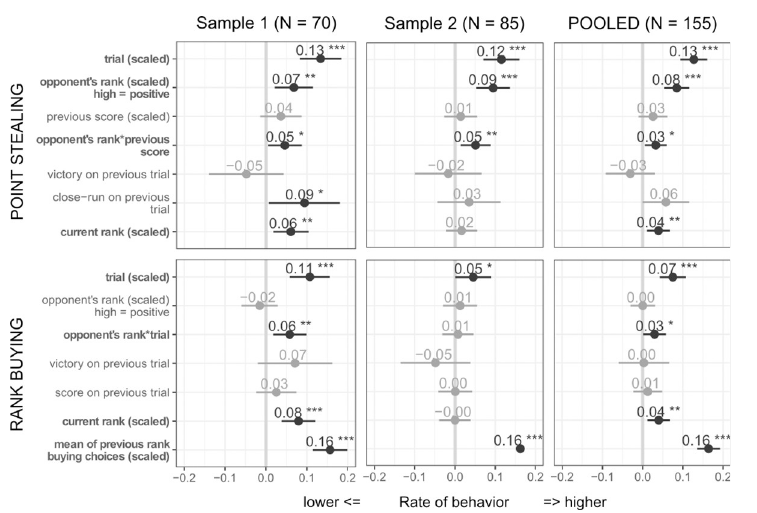
Fig 2. Models with design variables predicting point stealing and rank buying in the two samples and the pooled analysis. Estimates of demographic covariates present in the models are not displayed (age, sex, ethnicity, household income, education, game experience, depression); effects significant in the pooled analysis are in bold, significant coefficients within each table appear in darker gray. The significant positive effect of trial (i.e. time on task) on both point stealing and rank buying behaviors can be interpreted as a reaction to the increasing exposure to defeat (given the rigged outcomes). Opponent’s rank and player’s previous score � opponent’s rank were consistent predictors of point stealing across samples, indicating a preference for upward directed rivalry, especially after having performed well on the snake arcade game. The mean of previous rank-buying choices was included as a covariate in the model predicting rank buying since buying extra rank inflated participant’s own rank (see Methods - Statistical Analysis–Model Selection). Points and numbers indicate estimates of fixed effects; horizontal bars represent standard errors. Legend: � , p < .05; �� , p < .01; ��� , p <